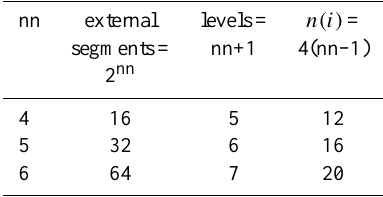
Table 1. The summary of the scaling which is N log N